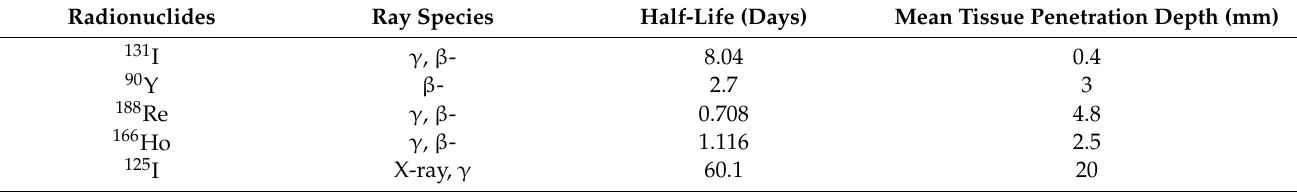
Table 1. Properties of radionuclides commonly used for